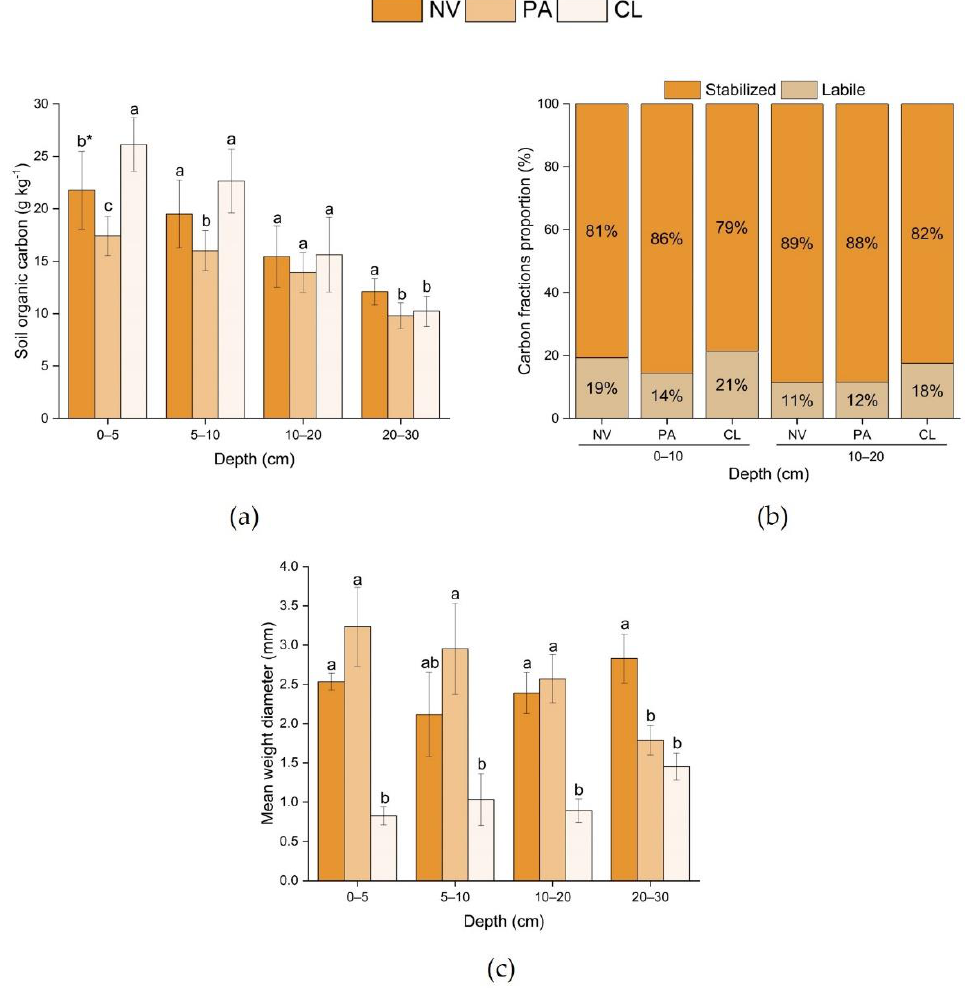
Figure 4. ( a ) Soil organic carbon content, carbon distribution at labile (particulate organic matter) and stabilized (mineral associated organic matter) fractions of soil organic matter ( b [34]), and mean weight diameter of soil aggregates ( c ) under cropland (CL), pasture (PA), and native vegetation (NV) areas. * Mean followed by the same letter within the same soil layer is equal to Tukey’s test ( p < 0.05). Vertical bars represent the standard deviation of the